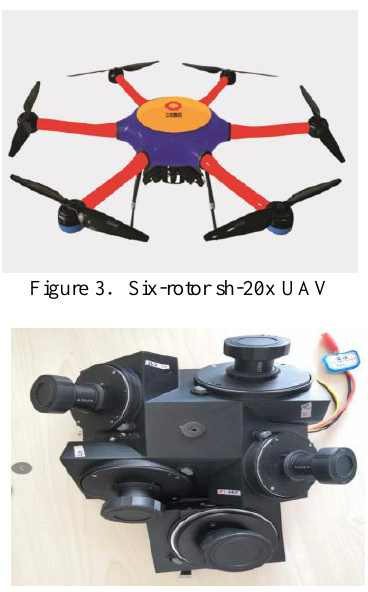
Figure 2 ． Fixed wing locust 3.0 UAV